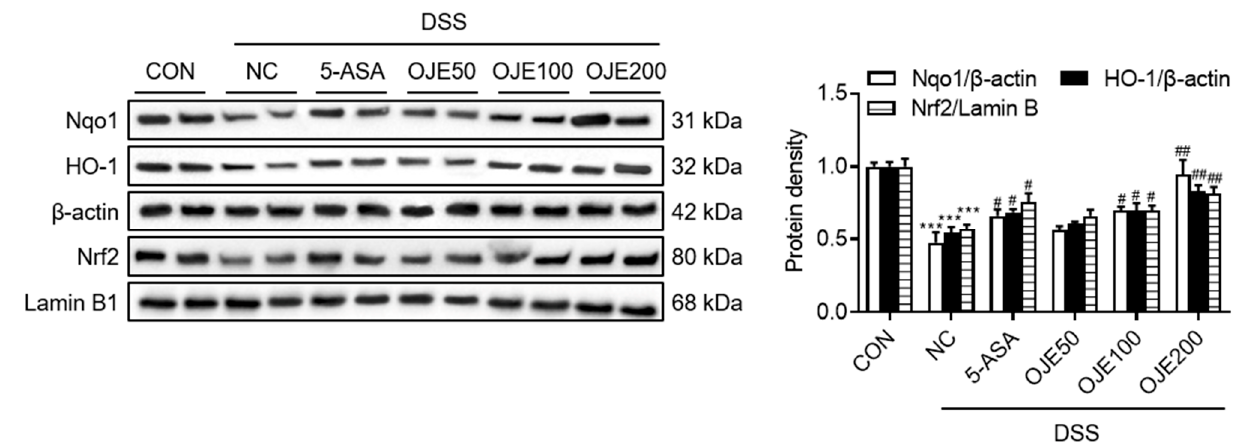
Figure 6. Effects of OJE on phase 2 antioxidant enzymes in mice with DSS-induced colitis. Protein expression of Nrf2, HO-1, and NQO1 in colon tissue. Values are the mean ± SEM ( n = 6). *** p < 0.001, NC vs. CON; # p < 0.05, ## and p < 0.01, 5-ASA 50 mg/kg, OJE 50 mg/kg, OJE 100 mg/kg, OJE 200 mg/kg vs. DSS+NC.